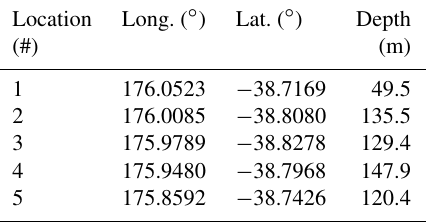
Table 2. Location of eruptive explosion cases, also see Fig. 2.